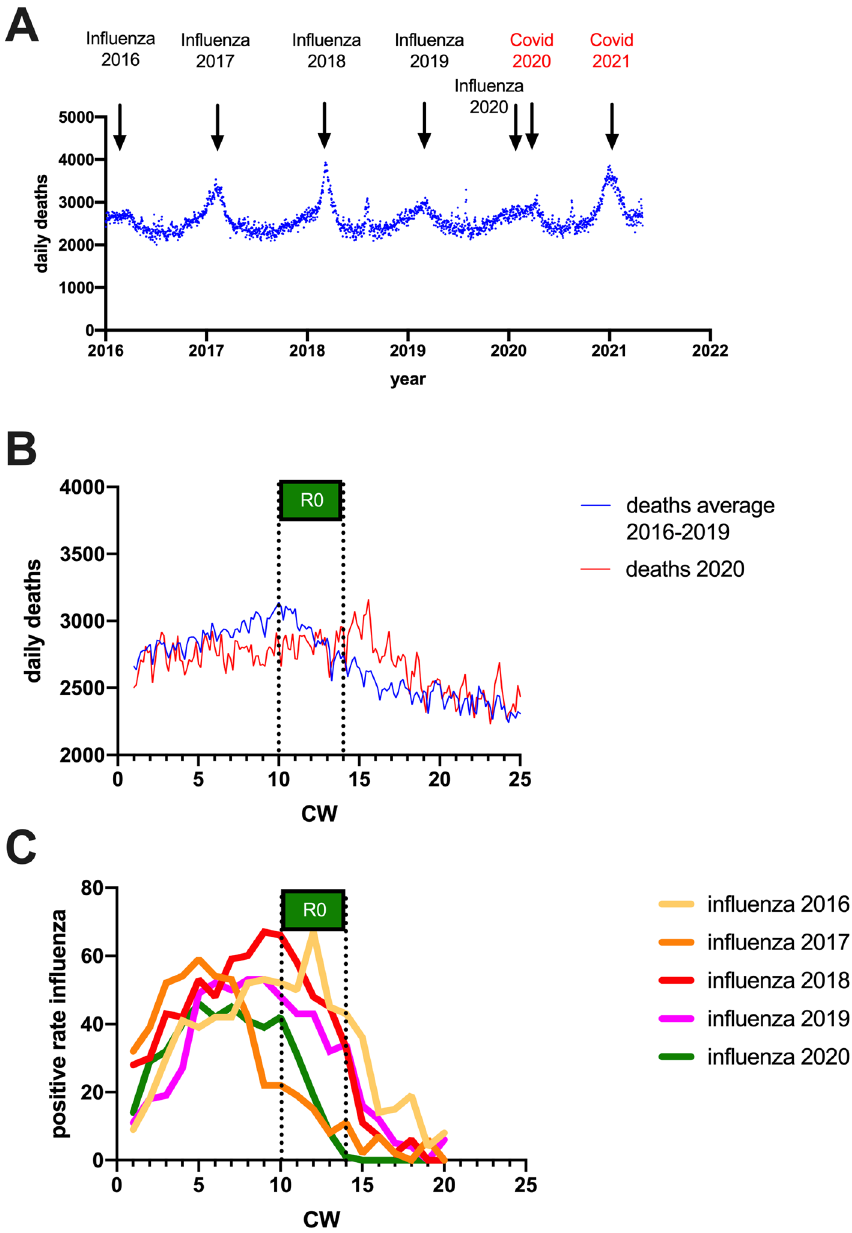
Figure 4. Comparison of Influenza-related and Covid-19 related mortality in Germany. ( A ) Daily deaths in Germany from 2016 to 2021 (data taken from the Federal Statistical Office of Germany). ( B ) Comparison of daily number of deaths in 2020 (red line) with average number of daily deaths in 2016–2019 (blue line). ( C ) Positive rate for influenza infections in Germany for calendar weeks 1–20 from 2016 to 2020 (data taken from the RKI influenza